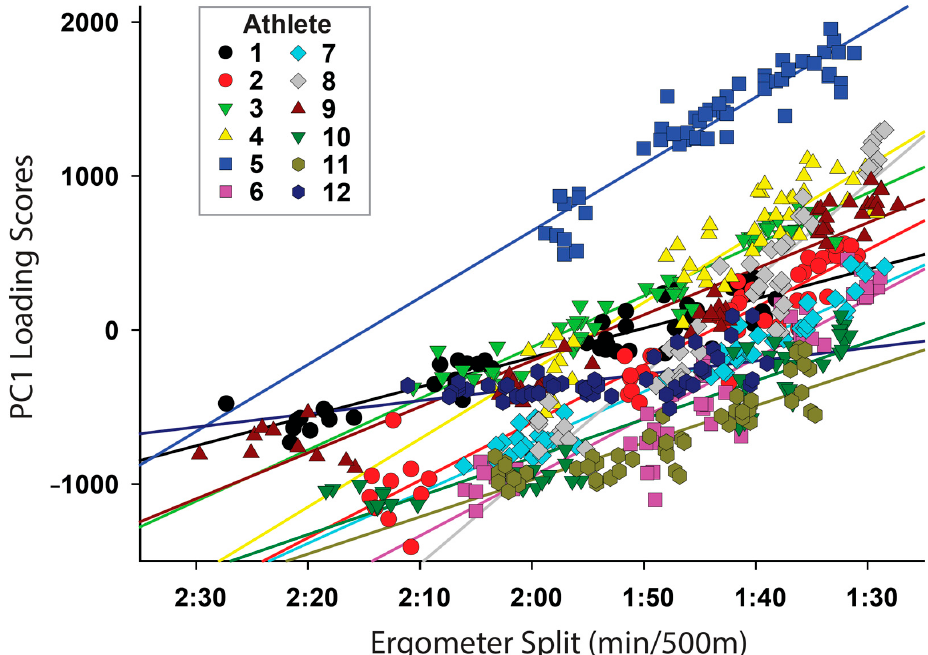
Figure 4. Relationship between rowing ergometer split and the loading scores for the kinematic patterns of PC 1 grouped by athlete. PC1 explained 26.4% of the signal and was significantly affected by split time ( p = 0.0001). PC1 loading score was correlated with the rowing ergometer split (r = 0.64). Athlete 12 had the lowest correlation (r = 0.57), and athlete 7 had the highest correlations (r = 0.97).